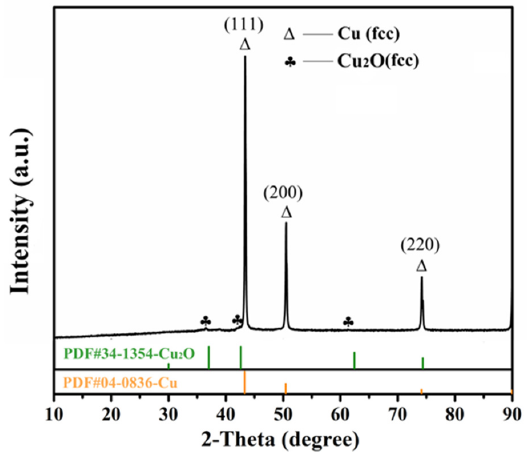
Figure 4. XRD diffraction of Cu nanoparticles.